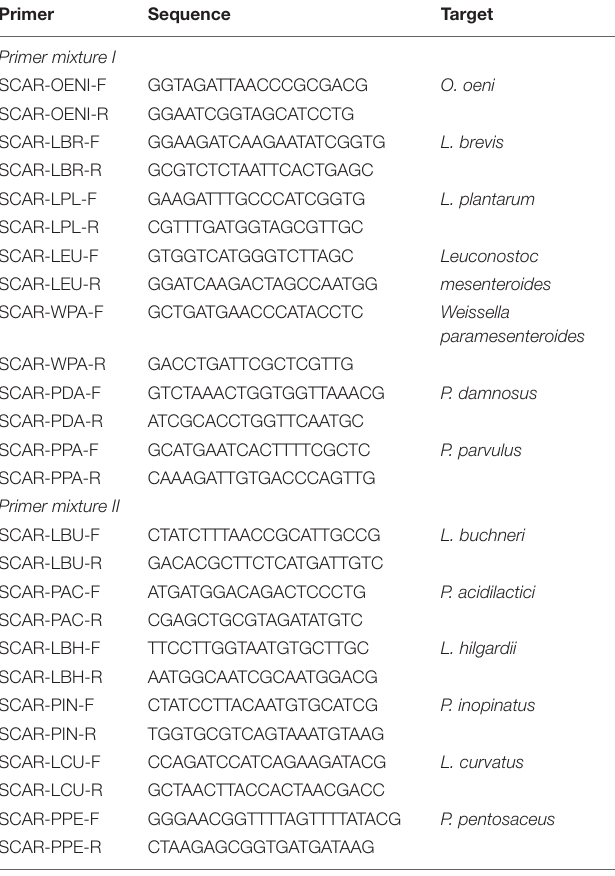
TABLE 3 | Number of samples handled and isolates obtained from the four wineries located in Queretaro, Mexico.